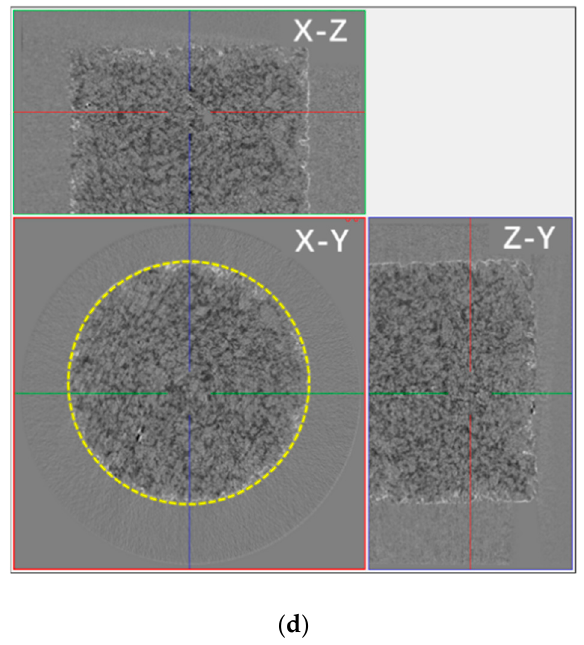
Figure 10. The distribution of water in the pore network and pores in the SiO 2 sample containing a saline solution during drying in micro-CT two-dimensional imaging. ( a ) The sample containing the NaCl solution after drying for 30 min and ( b ) after drying for 150 min. ( c ) The sample containing the Na 2 SO 4 solution after drying for 30 min and ( d ) after drying for 150 min. In the figure, X-Y, X-Z, and Y-Z respectively indicate the three directions of the tested sample. In the picture, black represents the solution, white represents the precipitated crystals, and the yellow circle represents the edge position of the sample.